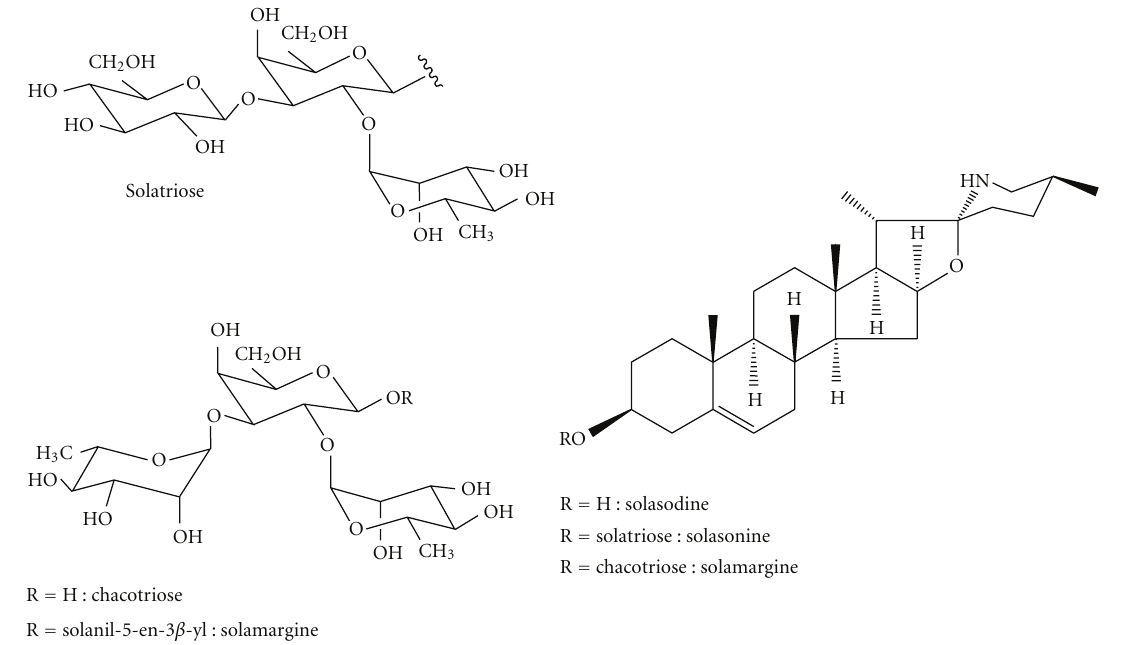
Figure 1: Chemical structures of solasodine and its respective